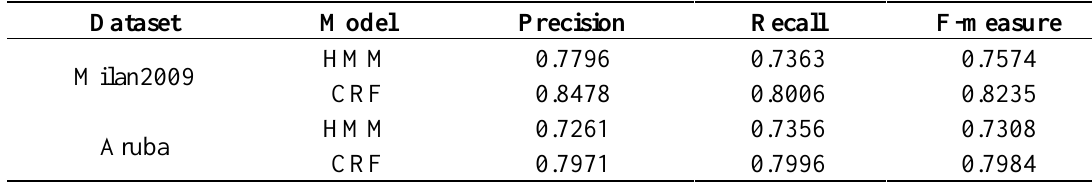
Table 5. Accuracy performance for action